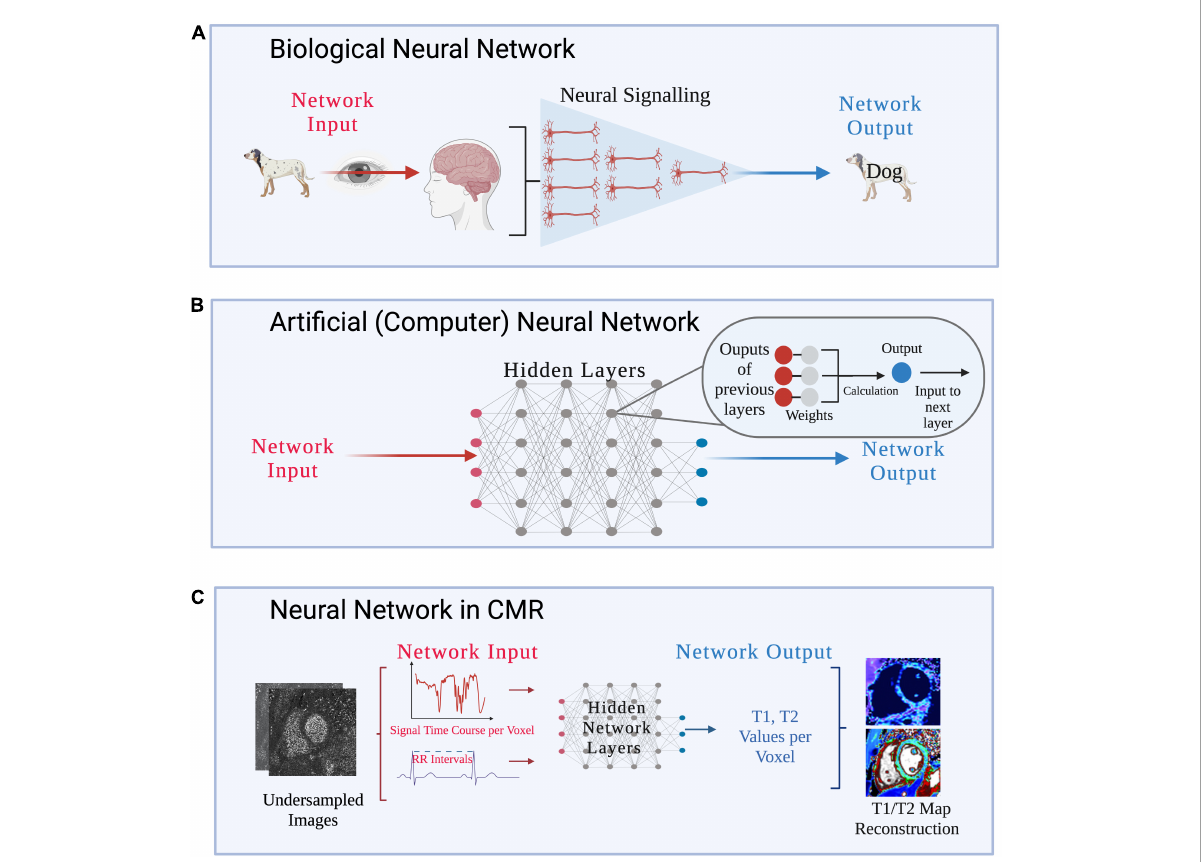
FIGURE11 (A) Biological neural network: pictorial depiction of visual processing by interconnected neurons in the human brain. Figure design inspired by Zhu et al. (128). (B) Artificial (computer) neural network: pictorial of an artificial (computer) neural network as used in DL methods. Neural networks are composed of multiple hidden layers of interconnected nodes, which parallel the human brain’s interconnected neural signaling pathways. Network inputs go through several layers of computations which not visible to the reader, and as such, these computations are known as hidden layers. Within each layer, filters are applied to the input, producing spatially dependent features which are then input to the next layer. The network aims to learn the optimal value of the filters, known as their weight, to generate features of maximum relevance to the task. If there are many layers, or computations, in the model, it is known as a deep neural network. (C) Neural network in CMR: a basic graphical representation of the deep neural network structure used to accelerate cardiac Fingerprinting (cMRF), as proposed by Hamilton and Seiberlich (106). After the network has been trained on simulated cMRF data, undersampled cMRF images are input and the network produces reconstructed T1/T2 maps. Specifically, for a given voxel, the measured cMRF signal time course and cardiac RR interval times from the ECG are input. The network then produces the estimated T1 and T2 values per voxel. This technique greatly accelerates reconstruction time from undersampled images, suggesting applications for rapid CMR reconstructions in clinical